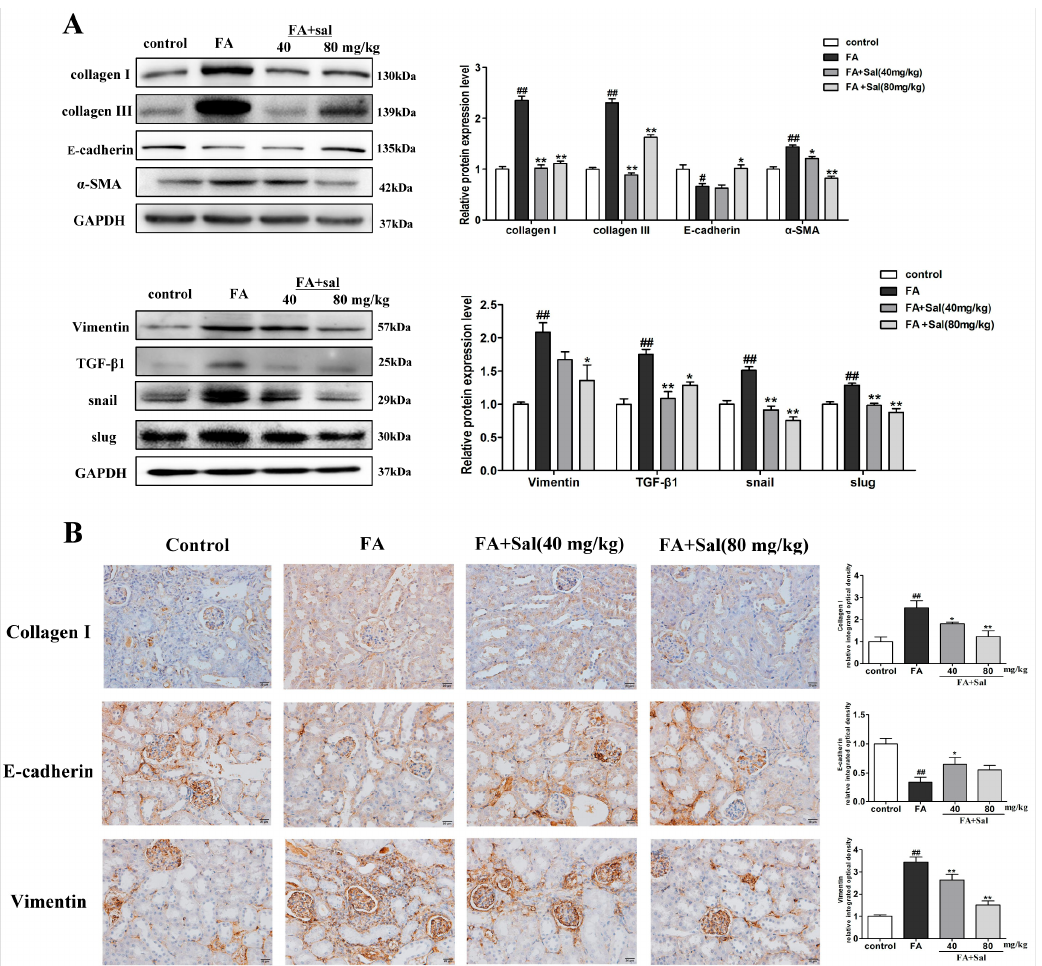
Figure 3. Sal reduced the accumulation of extracellular matrix (ECM) components and blocked EMT in FA mice. ( A ) Western blotting was performed to determine the protein expression levels of collagen I, collagen III, α -SMA, vimentin, E-cadherin, TGF- β 1, snail, and slug in the kidney tissue of FA mice ( n = 3). ( B ) Immunochemical staining of collagen I, E-cadherin and vimentin in the kidney tissue of FA mice ( n = 3). Original magnification: × 200. All data are represented as mean ± SD. # P < 0.05, ## P < 0.01 vs. control group, * P < 0.05, ** P < 0.01 vs. FA group.